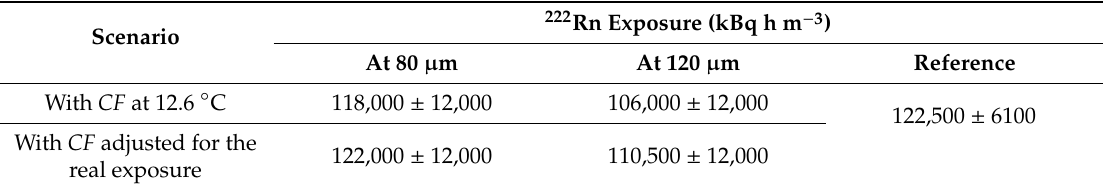
Table 1. Integrated 222 Rn activity concentration assessed by CDs with tracks analyzed at 80 µm and 120 µm beneath the front surface. The reference exposure was assessed by continuous measurements by a reference instrument AlphaGUARD PQ2000 Pro. CF = net track density/radon exposure.